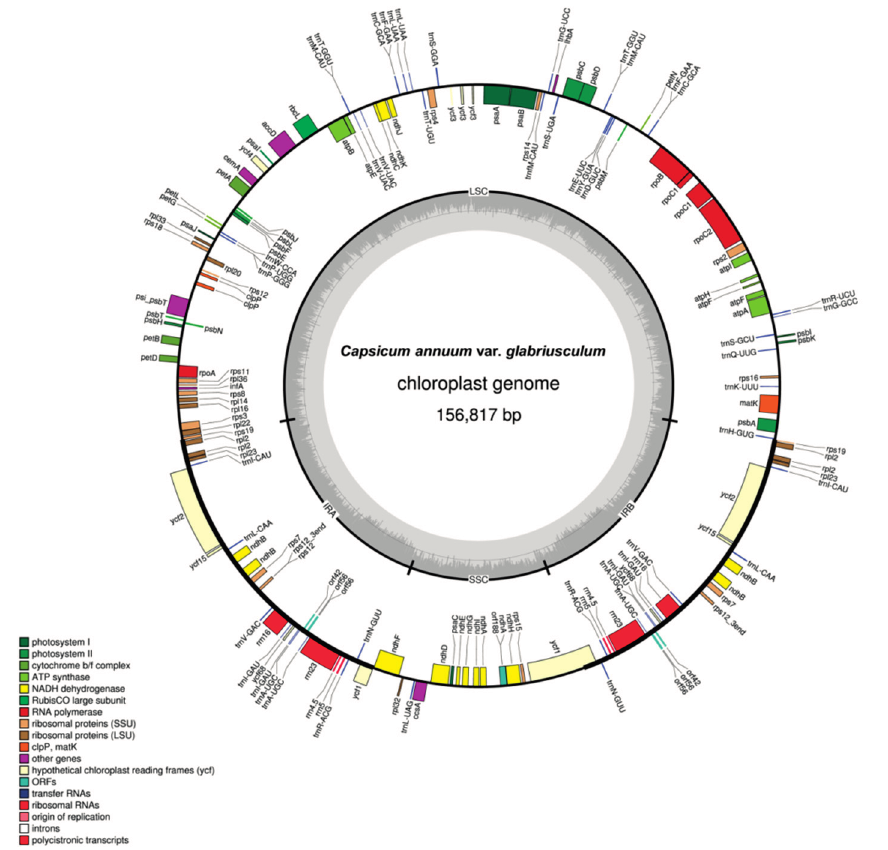
Figure 1. Complete chloroplast genome map of C. annuum var. glabriusculum . Genes drawn inside the circle are transcribed clockwise, and those outside are transcribed counterclockwise and marked by two arrows. Differential functional gene groups are color-coded. The GC content variation is shown in the middle